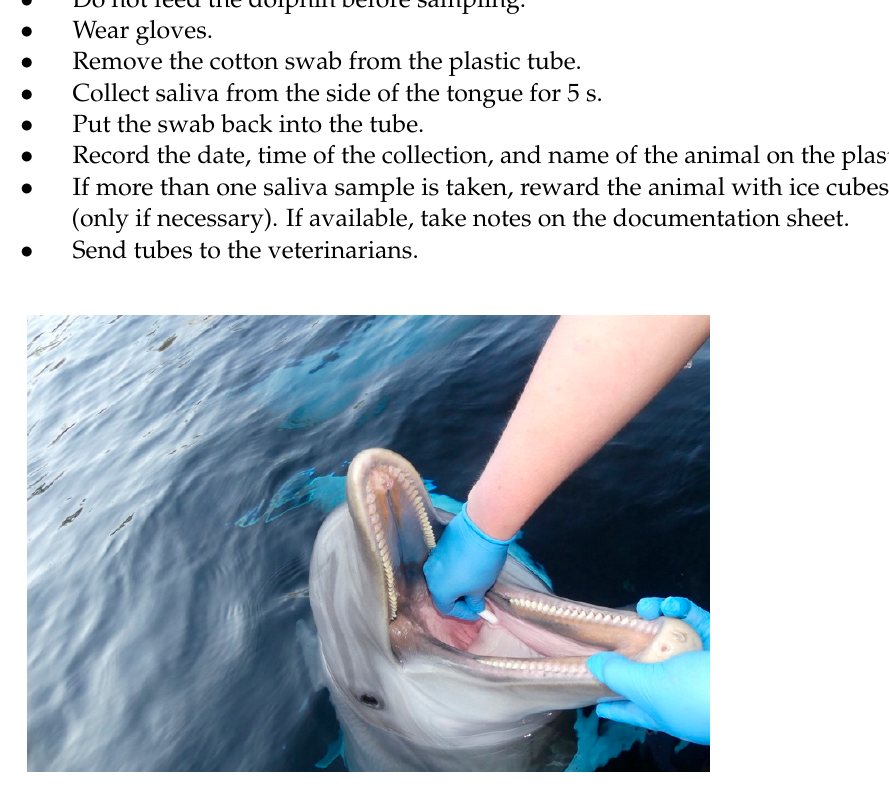
Figure A1. Saliva sampling, Image of the saliva sampling procedure. Table A1. Statistical results of the linear mixed-effect models (LMMs) fit by REML. The results show the effect of the treatment, test assay, and health status on the blood cortisol levels. Formula: log(Cortisol) ~ treatm + assay + health + (1 | dolphinID). Significance levels are indicated * p < 0.05 and *** p < 0.001.